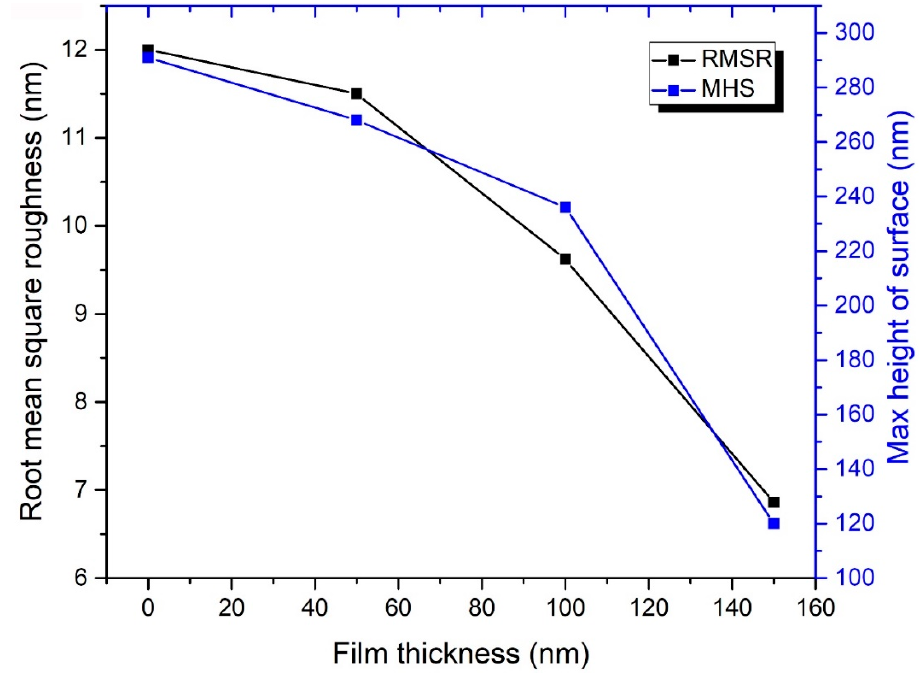
Figure 6. Root mean square roughness and maximum height of surface variation with deposition thickness on SS 316L substrates.